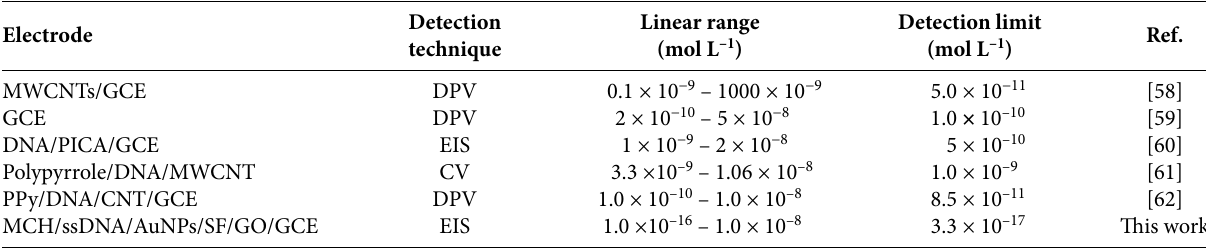
Table 1. Comparison of analytical performances of the MCH/ssDNA/AuNPs/SF/GO/GCE biosensor with several reported electrochemical DNA sensors for detection of breast